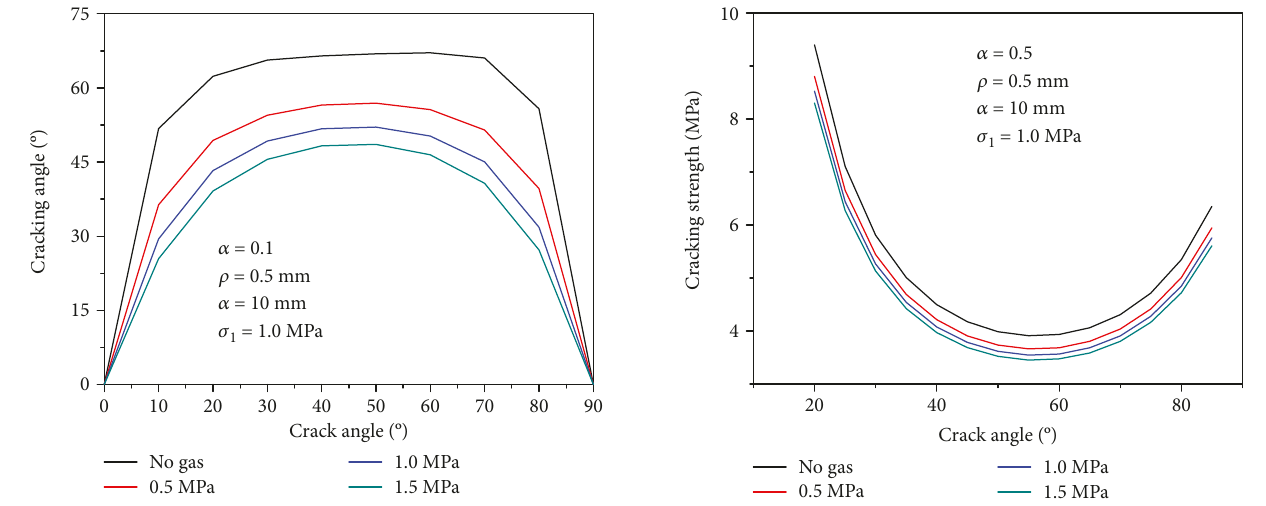
Figure 12: Relationship of cracking angle against cracking angle under di ff erent gas